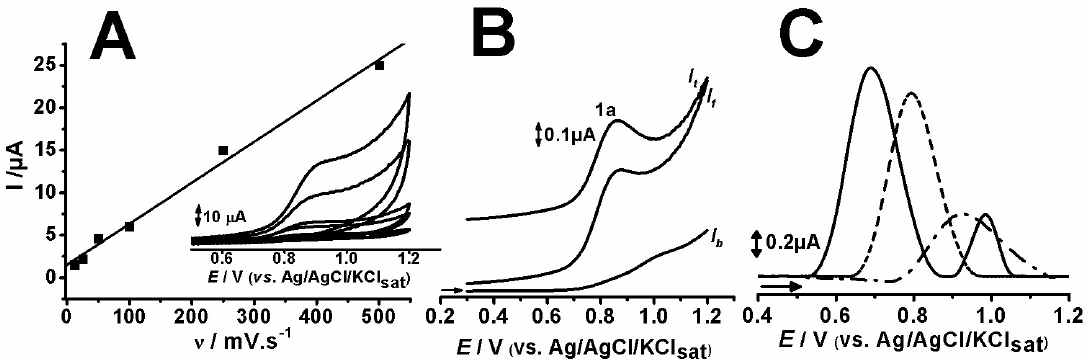
Figure 3. Cyclic voltammetry results at different scan rates (12.5, 25, 50, 100, 250, 500 mV.s −1 ) of 0.1 mM AMP in pH5 ACS ( A ); square wave voltammetry of 0.1 mM AMP in pH5 ACS ( B ); and differential pulse voltammetry of 0.1 mM CBP (—), AMP (- - -) and NOR (- – -) in pH 7 PBS ( C ).